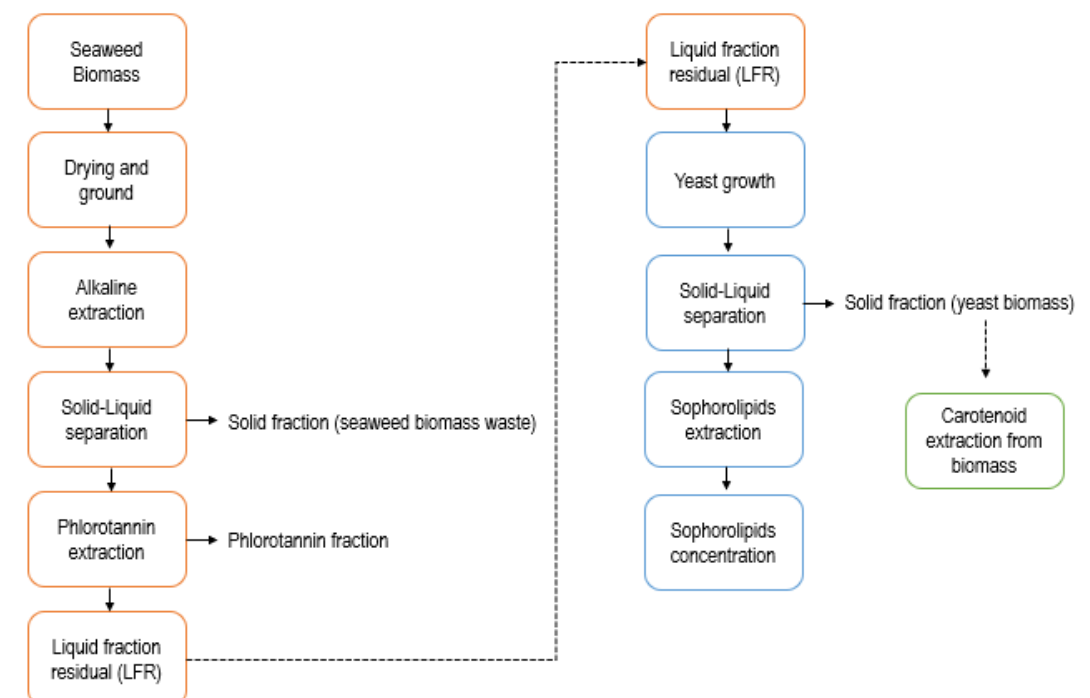
Figure 5. Liquid waste fraction (LFR) production and its sequential use for the production of antimicrobial compounds by the marine Rhodotorula rubra.